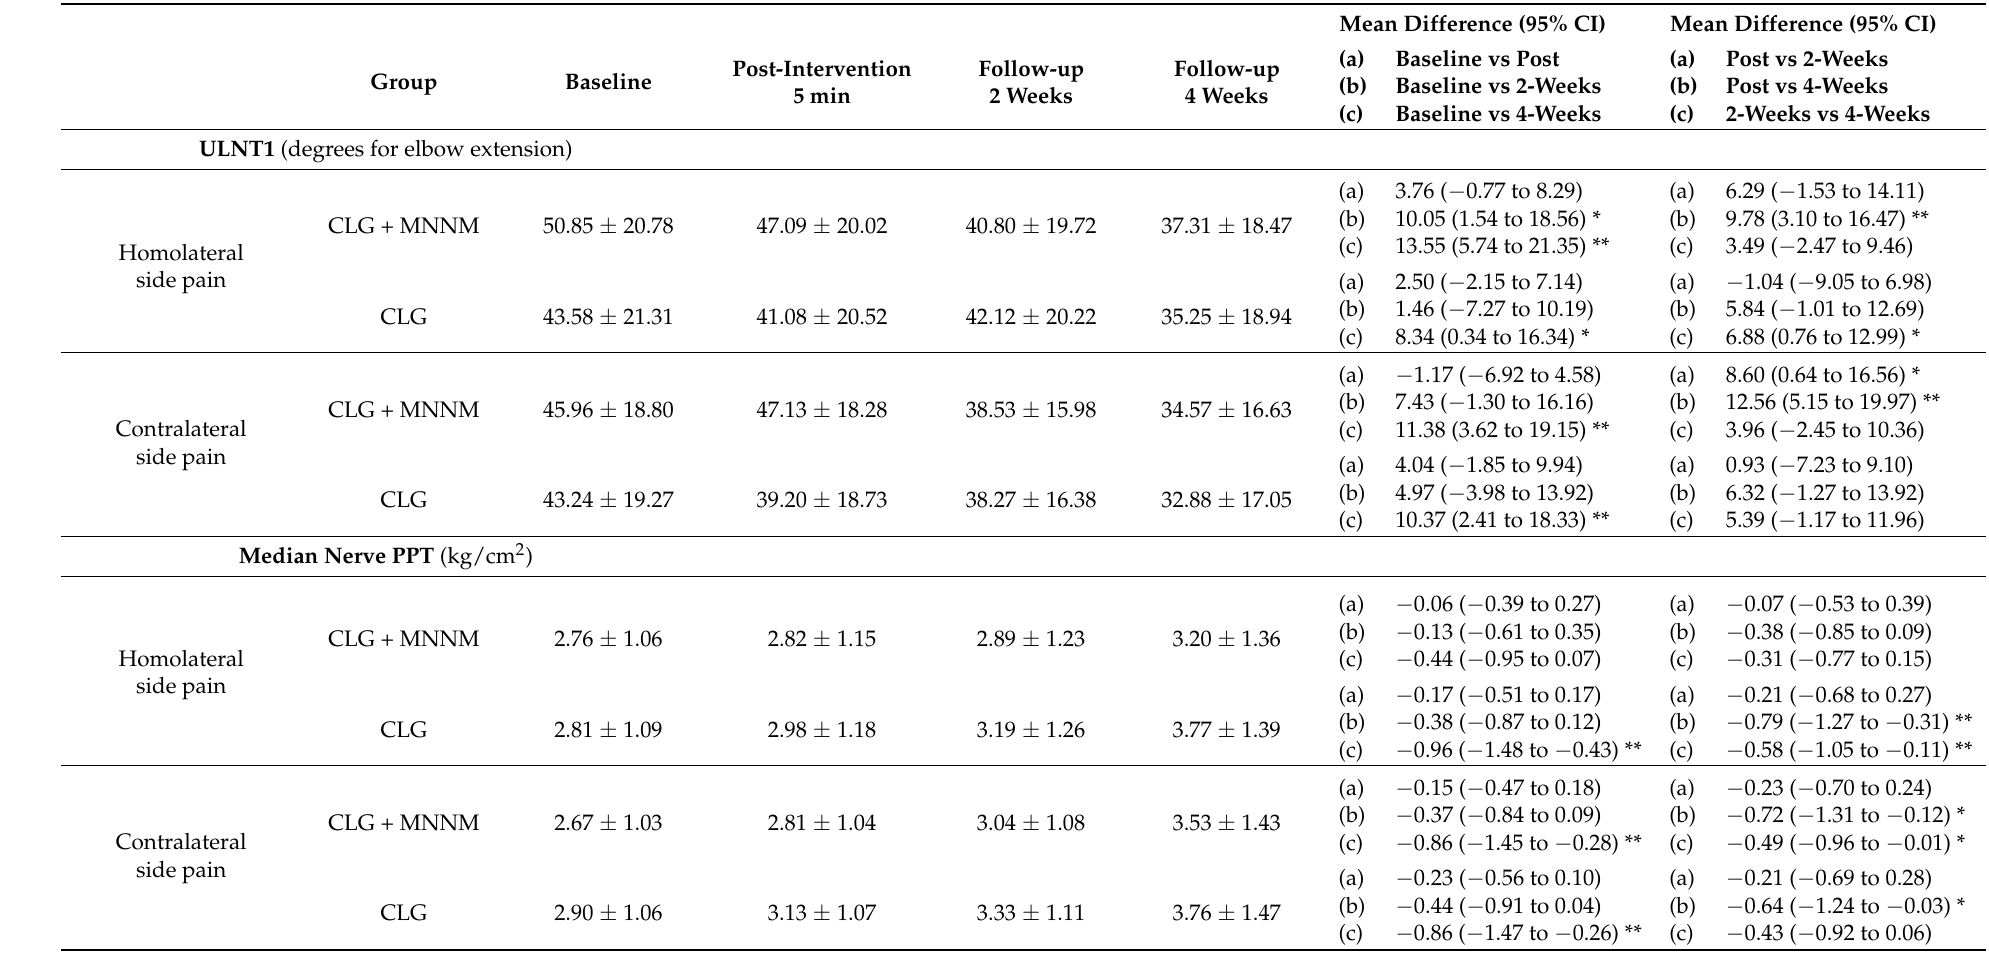
Table 2. Multiple comparisons for median nerve mechanosensitivity. Values are the mean ± standard deviation unless otherwise